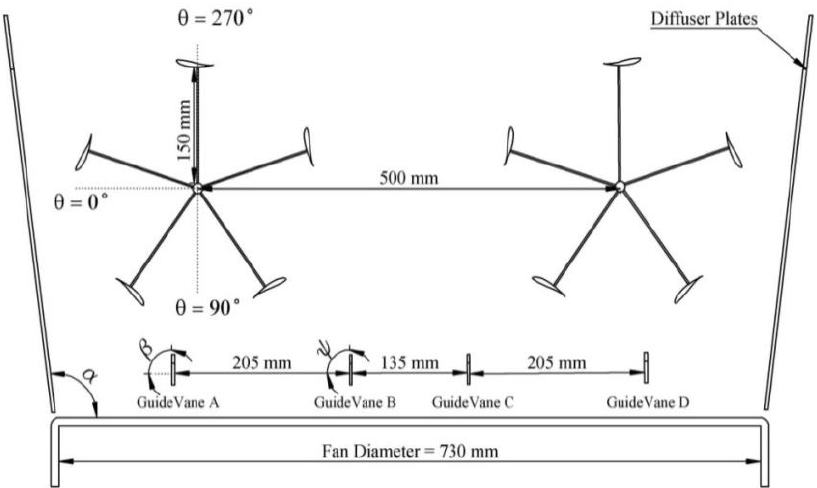
Figure 10. Two-dimensional (2D) model of the exhaust air energy recovery turbine.